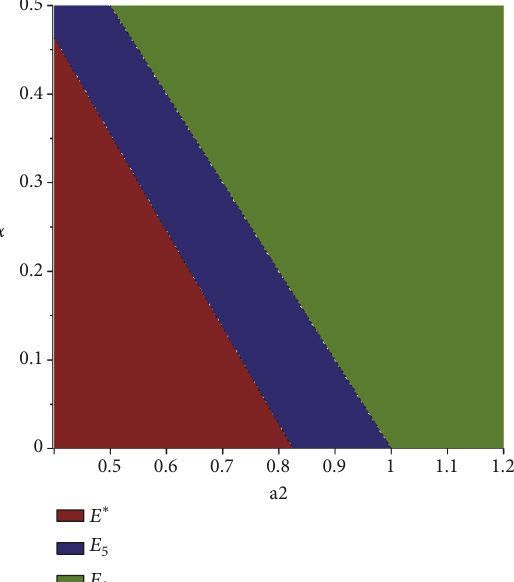
Figure 1: The stability regions of 𝐸 3 , 𝐸 5 and 𝐸 ∗ with respect to 𝑎 2 and 𝛼 . The parameter values are: 𝑟 = 1,𝐾 = 1,𝛽 = 0.1, 𝑐 = 0.01, 𝑐 1 = 0.5, 𝑐 = 0.25, 𝑘 = 1 , and 𝑘 = 0.5 . 2 1 2